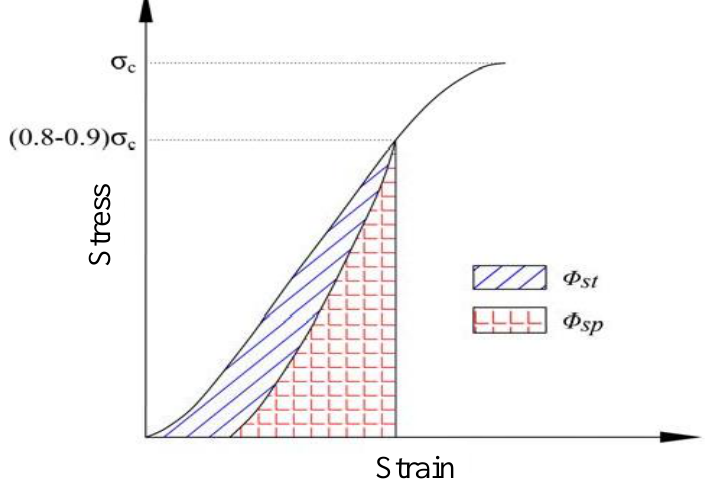
Figure 1. Schematic diagram of W et calculation based on uniaxial loading and unloading tests.